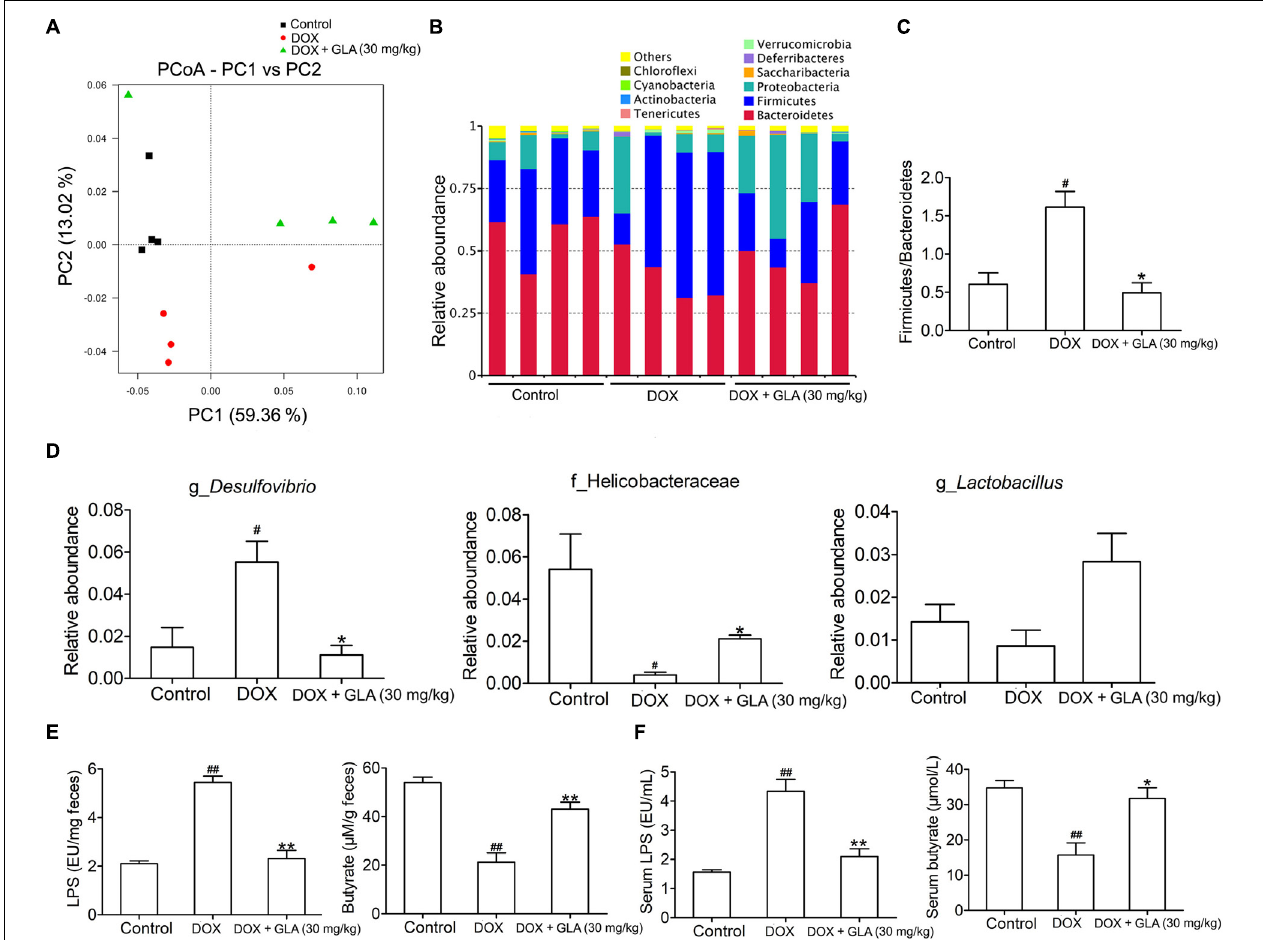
FIGURE 2 | Glabridin (GLA) prevents doxorubicin (DOX)-induced dysbiosis of gut microbiota in mice. A single dose of DOX (20 mg/kg) was intraperitoneally injected into the C57BL/6 mice to induce acute cardiotoxicity. GLA (30 mg/kg) or vehicle was intragastrically administered once daily for 12 days, starting 7 days before DOX injection. (A) Principal co-ordinates analysis plot of bacterial β -diversity ( n = 4). (B) The relative taxonomic abundance at the phylum level of gut microbiota ( n = 4). (C) The ratios of Firmicutes/Bacteroidetes ( n = 4). (D) The relative abundance of Desulfovibrio genus, helicobacteraceae family and Lactobacillus genus ( n = 4). (E,F) Lipopolysaccharide (LPS) and butyrate levels in feces and peripheral blood were determined by Limulus Amebocyte Lysate (LAL) assays or high performance liquid chromatography (HPLC), respectively ( n = 10). The values are presented as the mean ± SEM. # P < 0.05, ## P < 0.01 vs. control, ∗ P < 0.05, ∗∗ P < 0.01 vs.